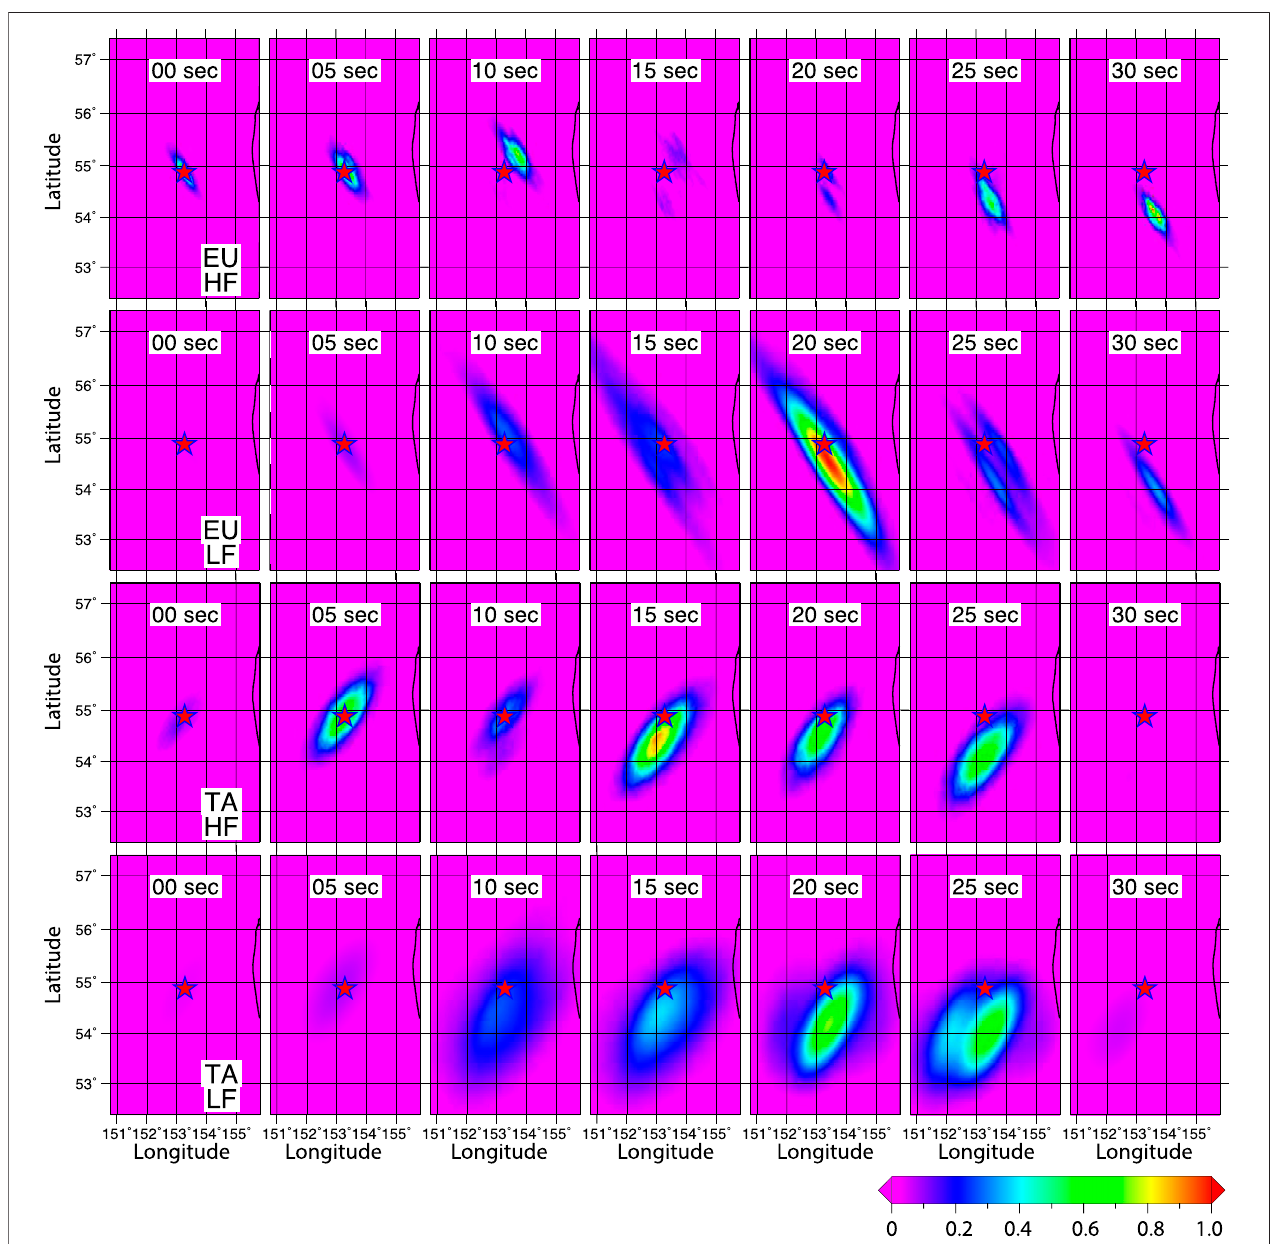
FIGURE 3 | Rupture evolution of the earthquake by back-projecting P -waves from the arrays TA and EU in the high- (HF) and low-(LF) frequency bands. The color bar denotes the normalized power of potential subevents. The potential subevents with the maximum power at each time frame are viewed as the true subevents. Red star indicates the